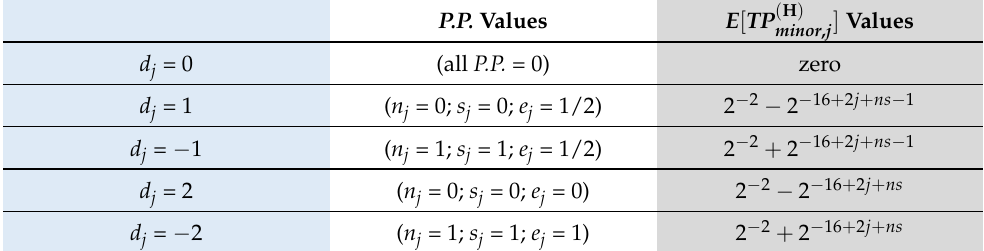
Table 3. Values of ( n j , s j , e j ) and according to d j . P.P. Values